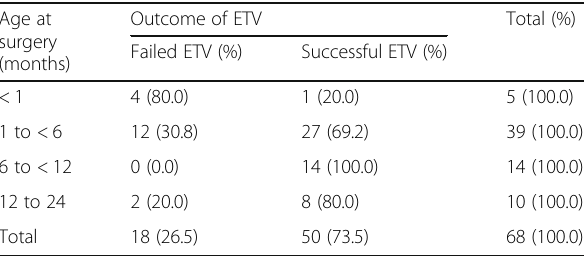
Table 3 Comparison of age at surgery with outcome of ETV using ANOVA Age at surgery